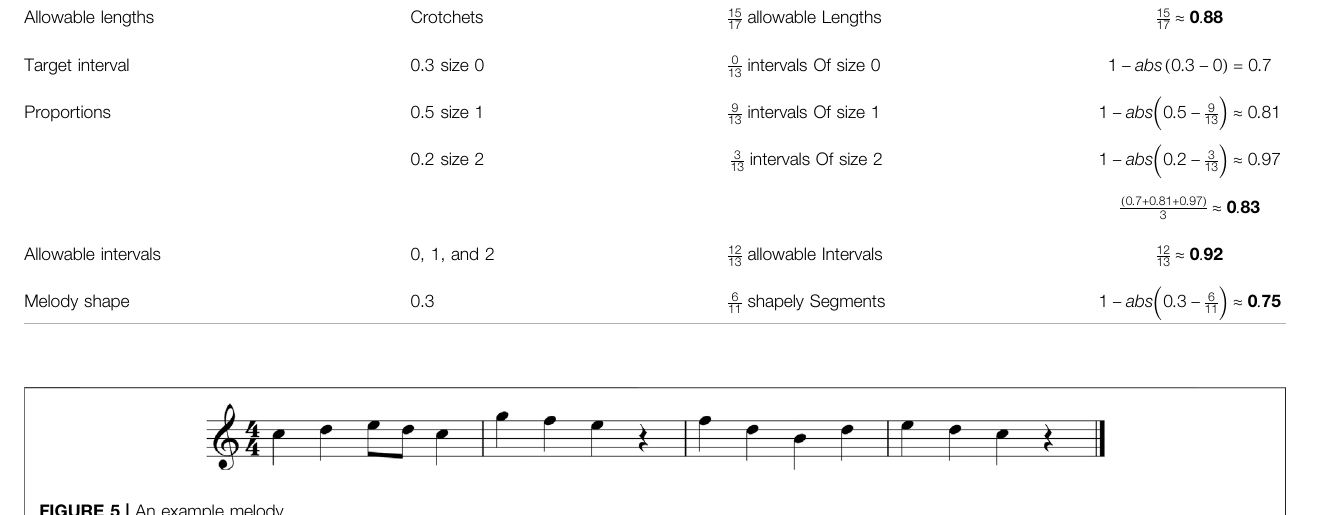
FIGURE 5 | An example